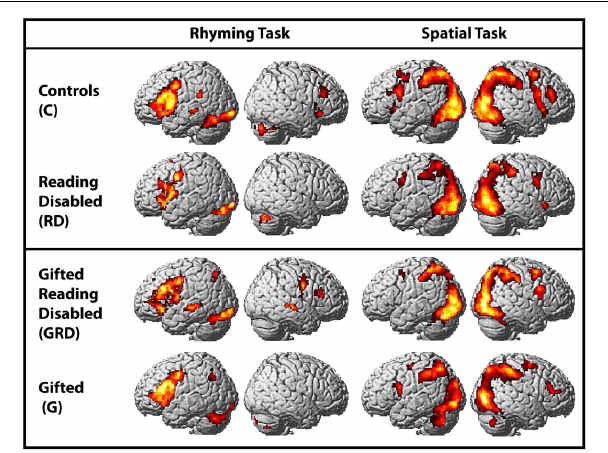
FIGURE 2 | Activations induced in the whole-brain for within-group comparisons for the word and spatial assessments (also see Table 4). Columns 1 and 2: Within group activation maps for the word reading task. Significant clusters observed in left inferior frontal and occipitotemporal regions. Columns 3 and 4: Within group activation maps for the spatial task. All maps are presented at a threshold of p < 0 . 001; cluster-size corrected for multiple